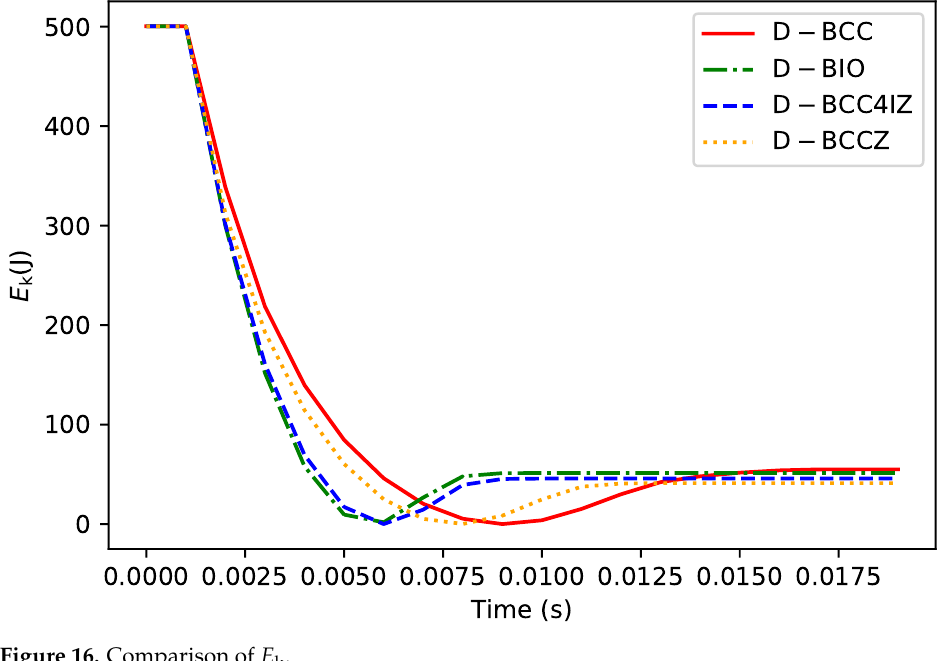
Figure 16. Comparison of E k .